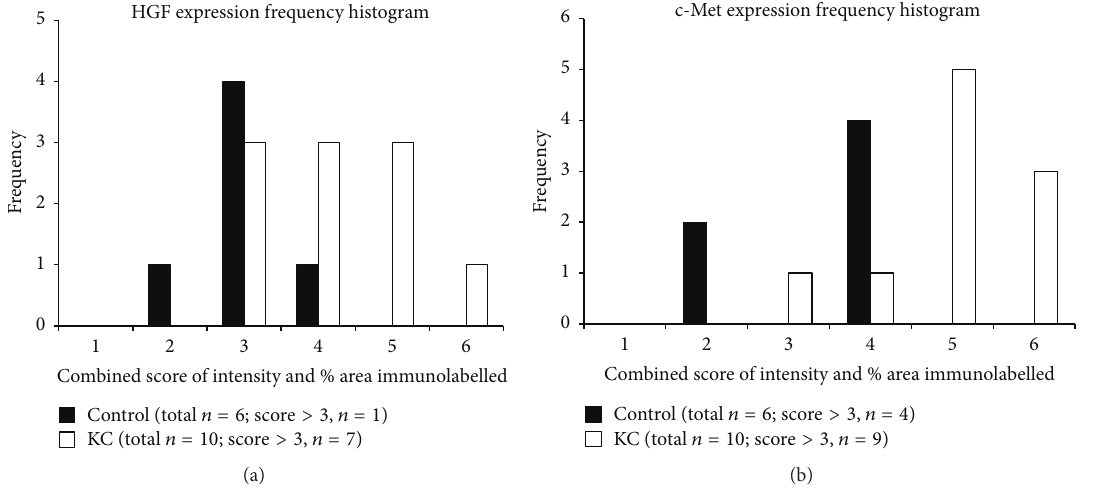
Figure 4: Frequency histograms for HGF (a) and c-Met (b) expression in KC and control corneas (combined score of staining intensity and % area coverage; range = 0 to 6). Note the right skewed distribution of HGF and c-Met immunostaining for KC corneas compared to controls. HGF staining had a combined score > 3 in 7/10 (70%) KC corneas, compared to 1/6 (16%) control corneas. c-Met staining with a combined score > 3 was seen in 9/10 (90%) KC corneas compared to 4/6 (66%) control